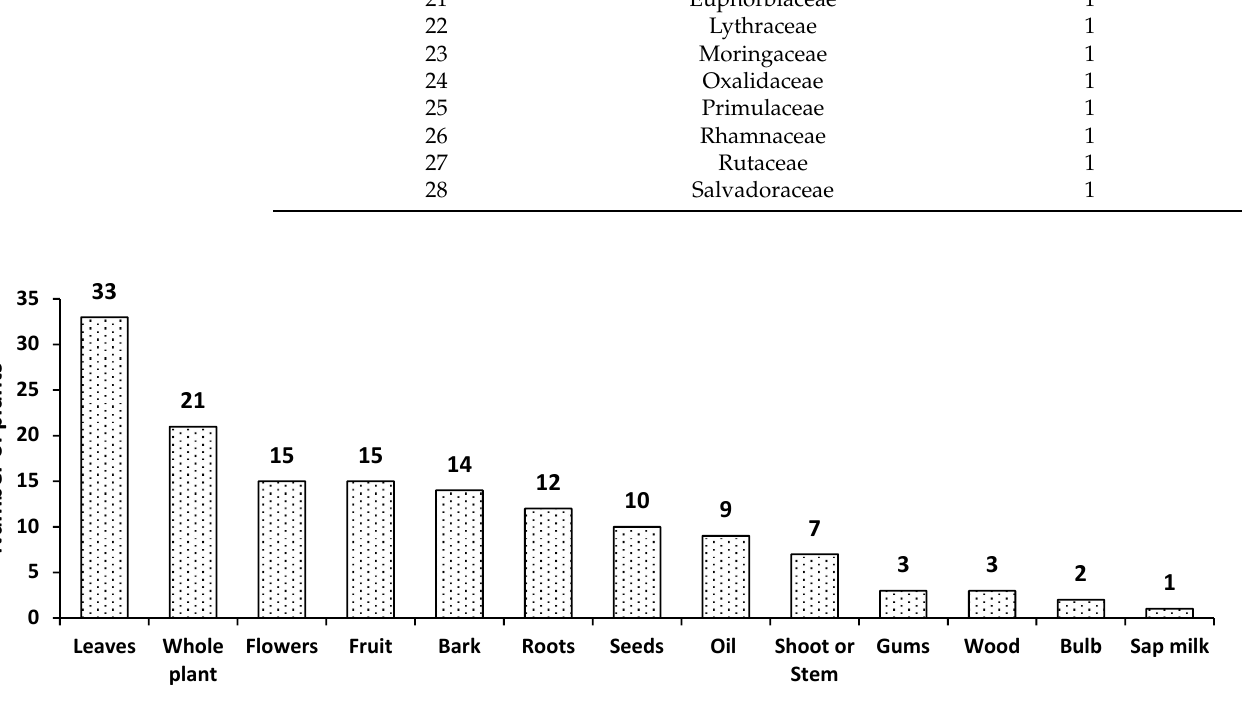
Figure 3. Plant parts used.